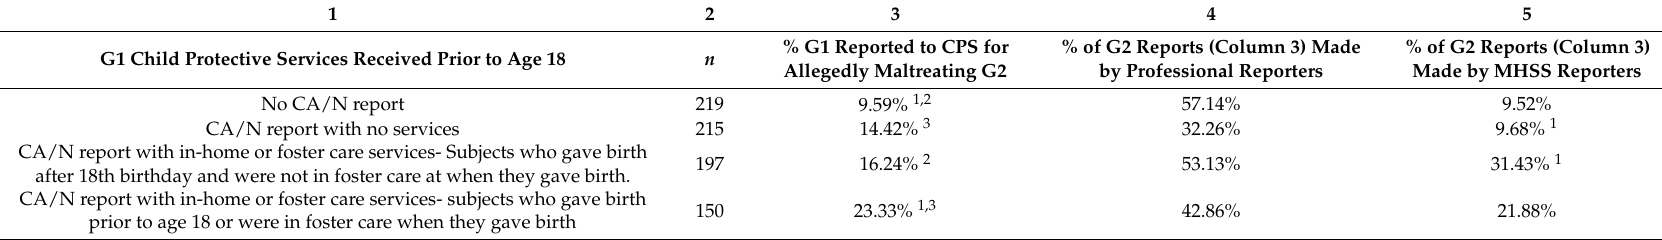
Table 3. Intergenerational report characteristics for adult female parents by level of their childhood CPS contact (Regional